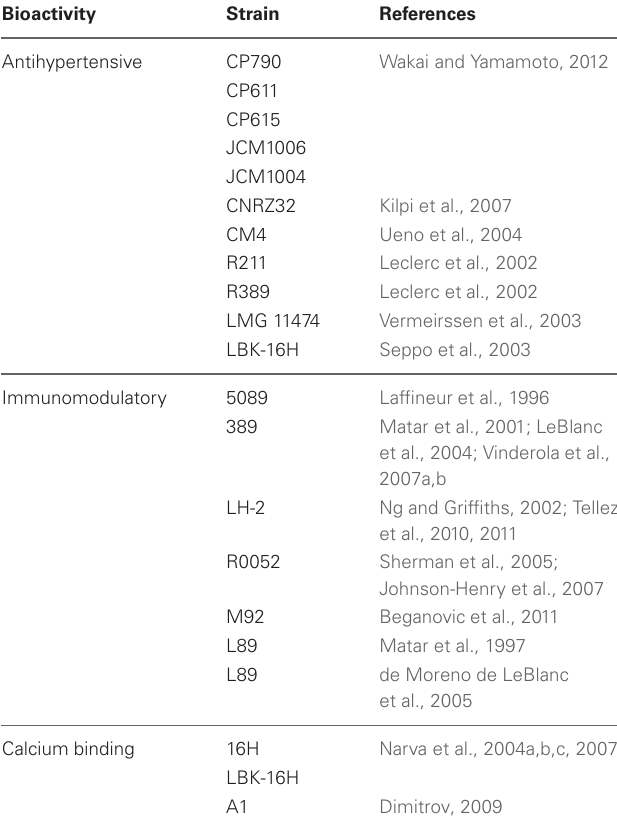
Table 2 | Bioactive peptides produced from hydrolysis of milk proteins by L. helveticus